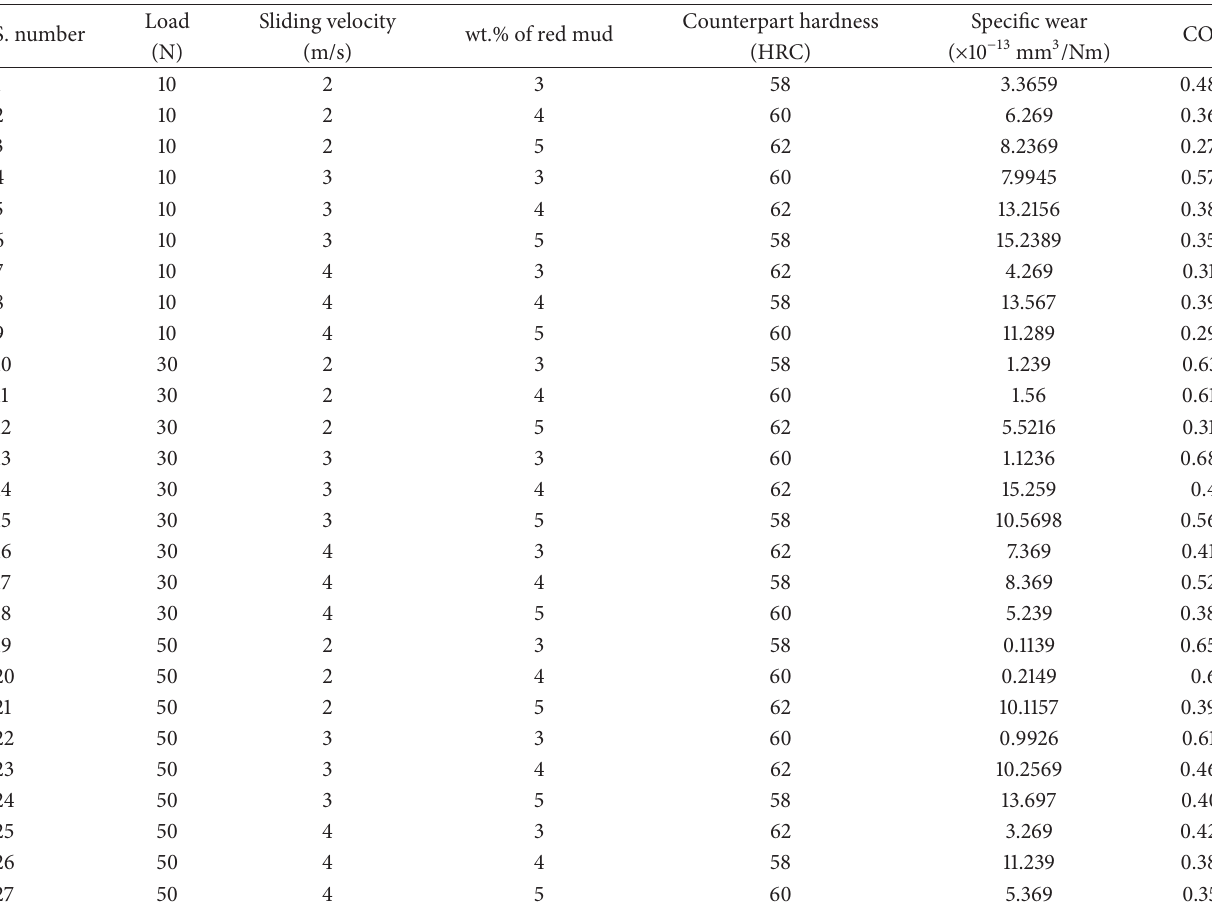
Table 1: Experimental layout and